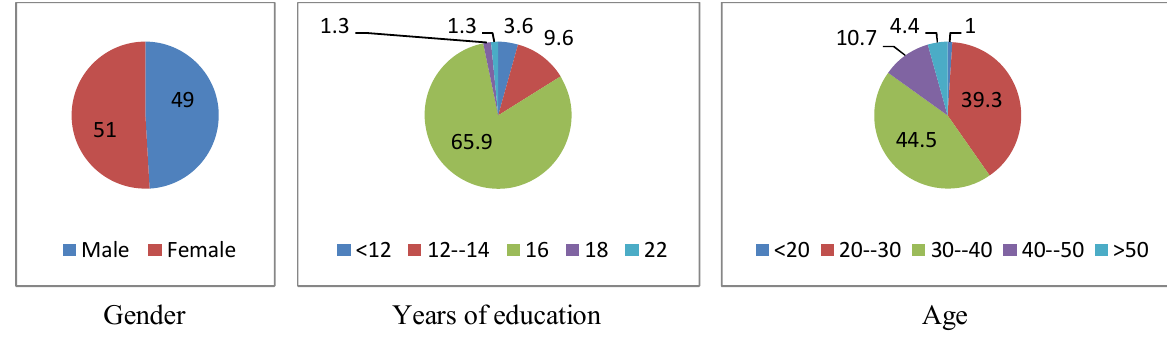
Fig. 2. Personal characteristics of the